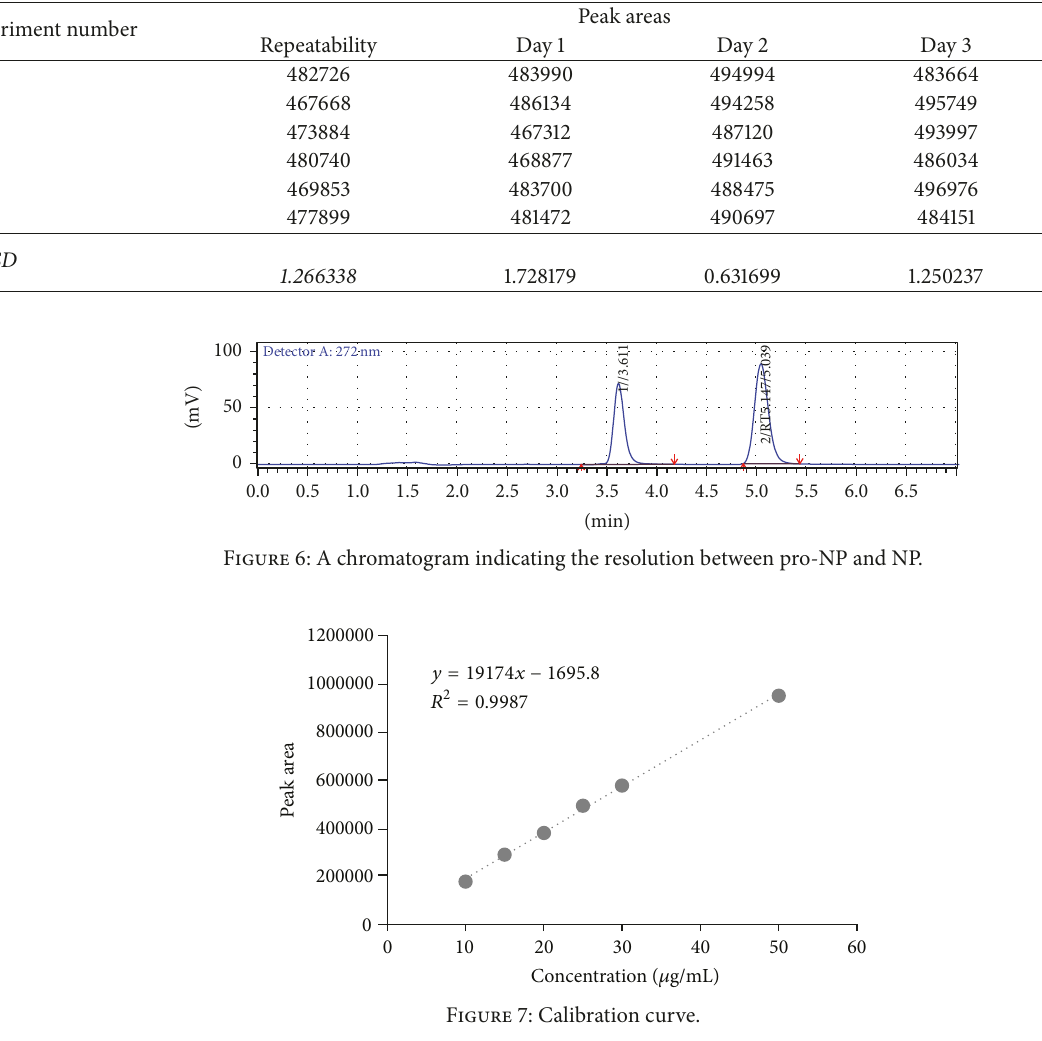
Table 4: Data from the precision evaluation.